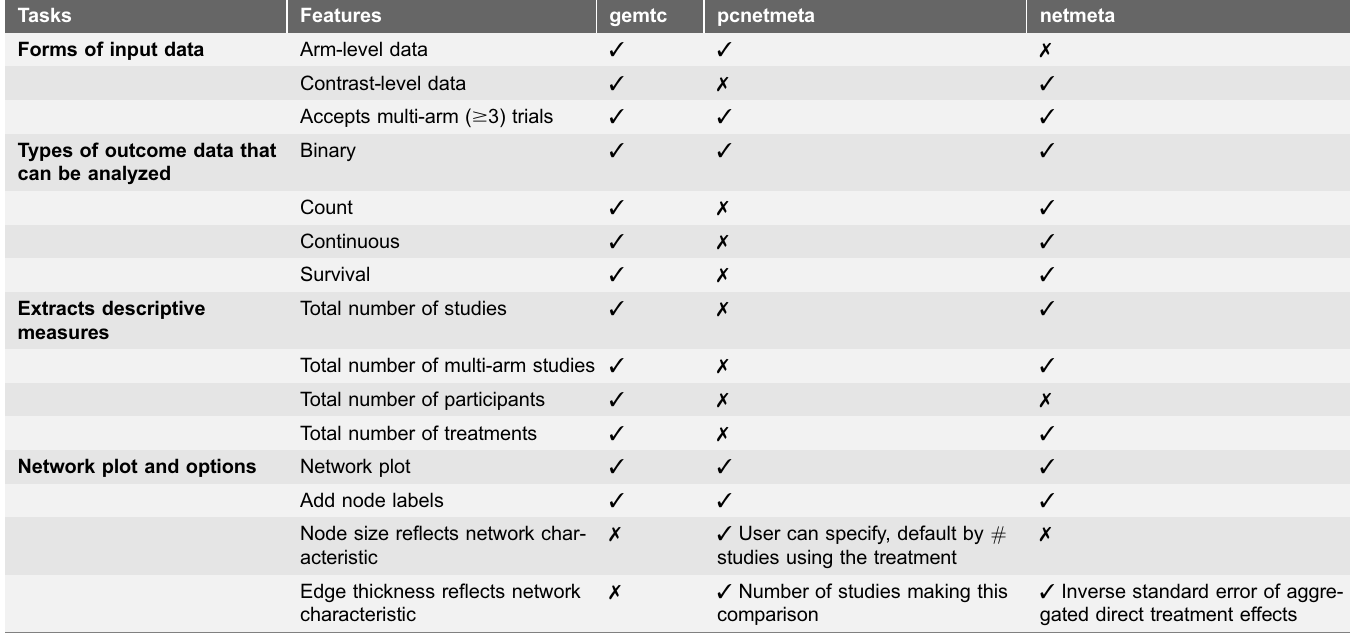
Table 1. Data input and network plotting functionality from NMA R packages gemtc, pcnetmeta and